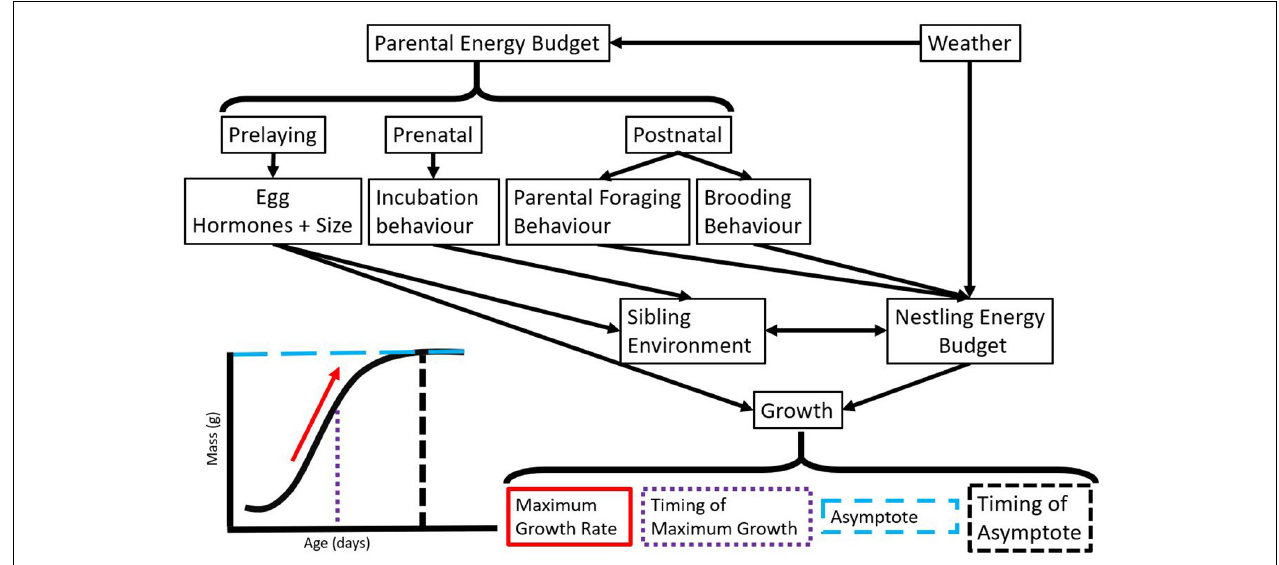
FIGURE 3 | Paths by which weather can impact variation in growth as described by parameters estimated from a general logistic curve. While we display physical growth in this figure, it will be useful to map the development of tissue functions (e.g., cognition, thermoregulation, motor function) onto this growth curve to compare and contrast development and physical growth over the nestling period. Many of the factors that impact growth are also likely to impact development.